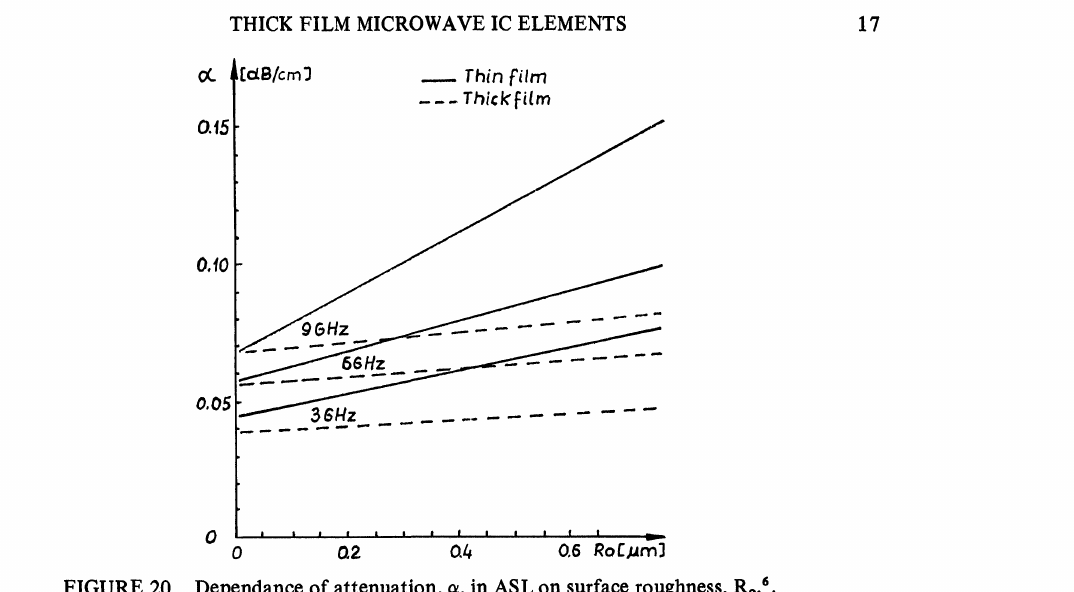
FIGURE 20 Dependance of attenuation, tx, in ASL on surface roughness, Ra,